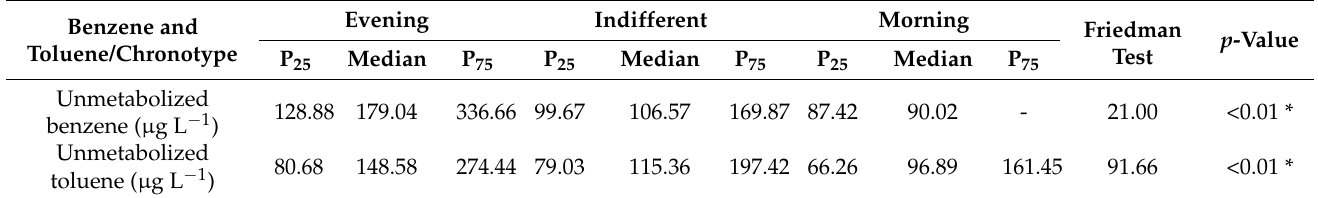
Table 7. Concentrations of unmetabolized benzene and toluene in urine ( µ g L − 1 ) according to PER3 gene VNTR